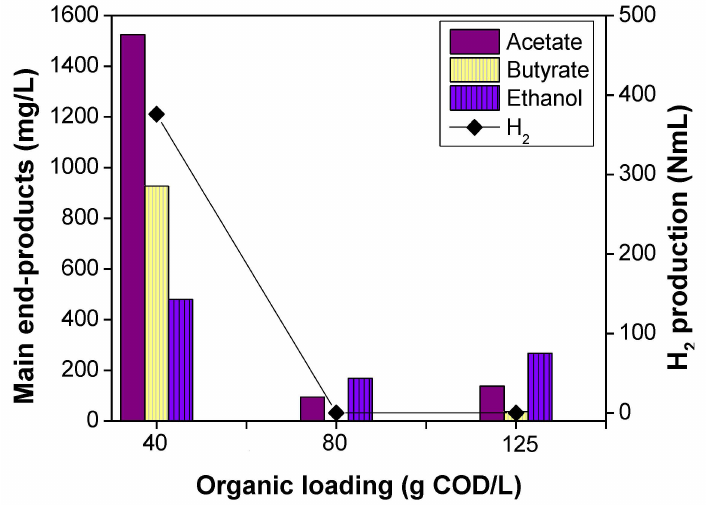
Figure 4. Effect of organic loading on thermophilic OMW DF under pH 6.0.